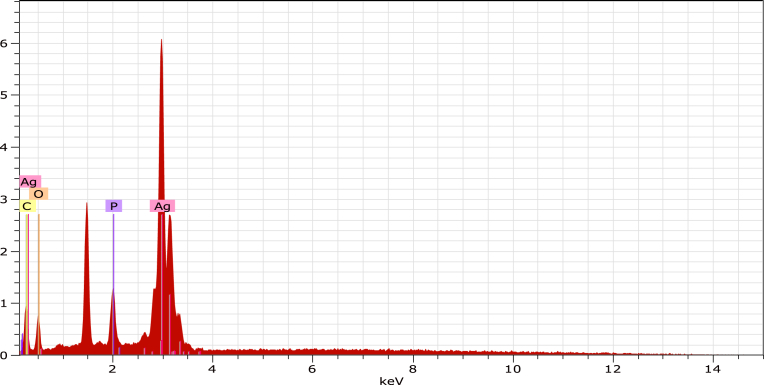
EDS analysis of the Ag3PO4.